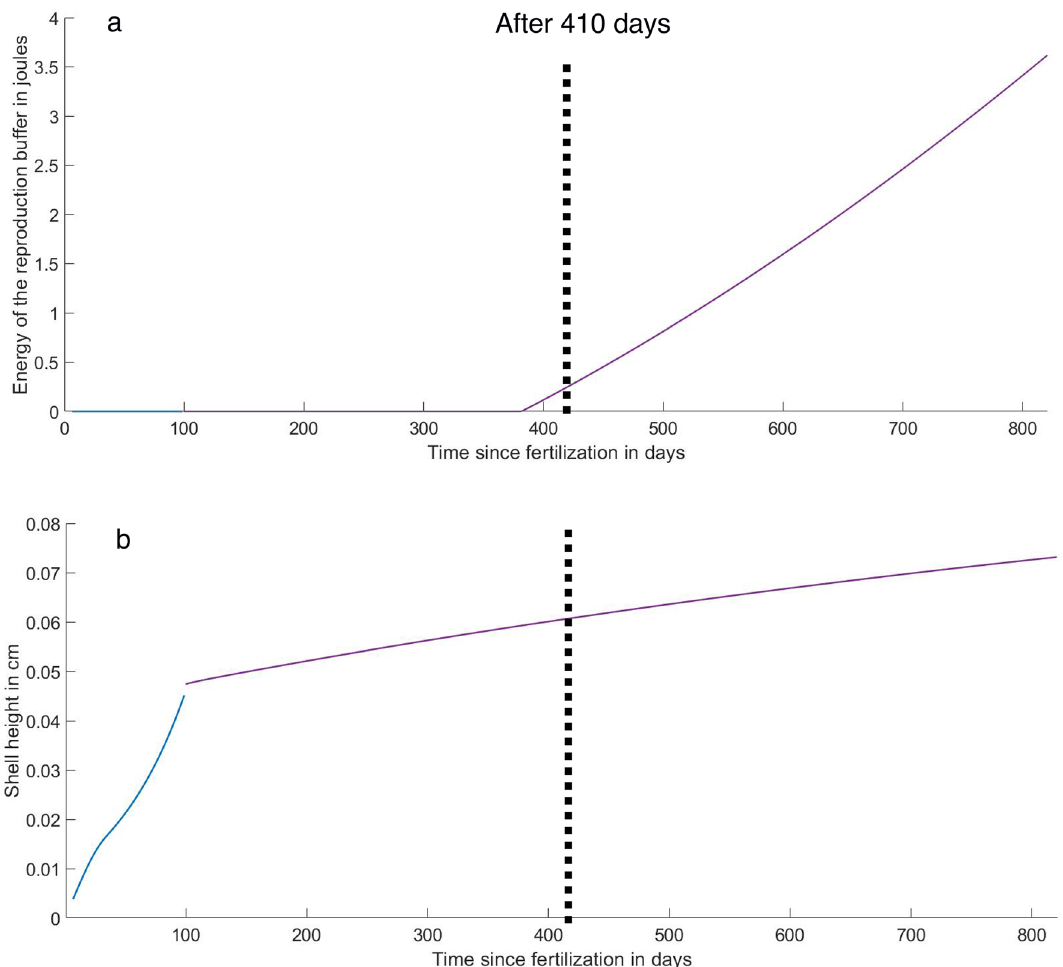
Figure 4. Prediction of the abj-DEB model of the evolution of ( a ) the shell height of dwarf male Xylonora atlantica at 2300 m in depth by changing κ to 0.06 with f = 0.8 while settling (in purple). ( b ) Change (in purple) in the energy stored in the reproduction buffer at T = 4 °C and f = 0.8 after metamorphosis (in